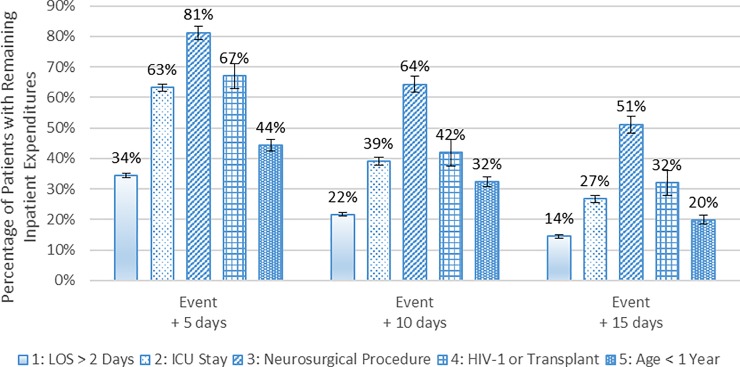
Percentage of hospitalized patients with meningitis who had inpatient expenditures after the subgroup-defining event, 2010 to 2014.Notes: The first 90 days and the last 90 days are excluded from the 2010 to 2014 period. For patients in Subgroup 4 (HIV-1 or Transplant) and Subgroup 5 (Age < 1 year), the subgroup-defining event day is the same as the initial hospital admission day because these patients could be classified into these subgroups upon admission. The values reported in the figure are the estimated percentages, and the error bars indicate the 95% confidence intervals of those estimates. Source: Authors’ analysis of 2010 to 2014 Truven Health MarketScan Commercial Claims and Encounters Database.